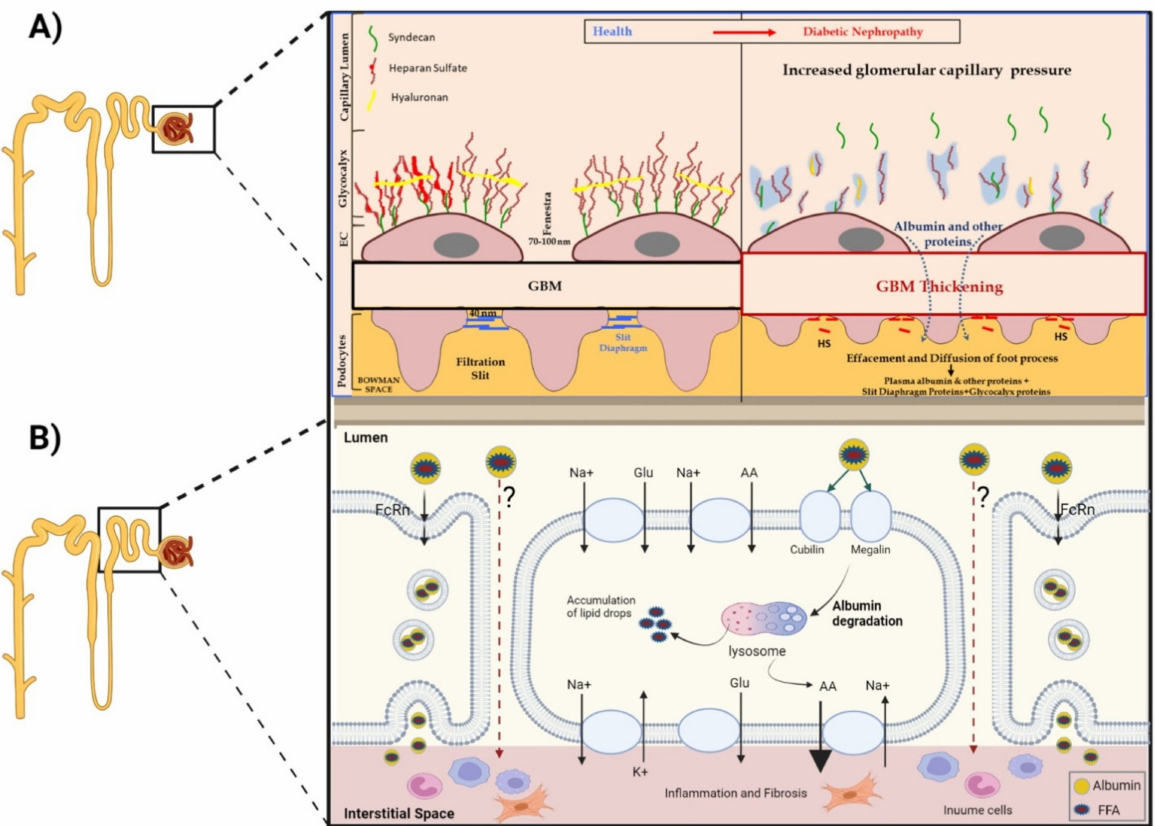
Figure 3. ( A ) Impact of DM on the ultrastructure of the various layers constituting the glomerular filtration barrier (GFB). ( B ) Pathways of tubular reabsorption of filtered